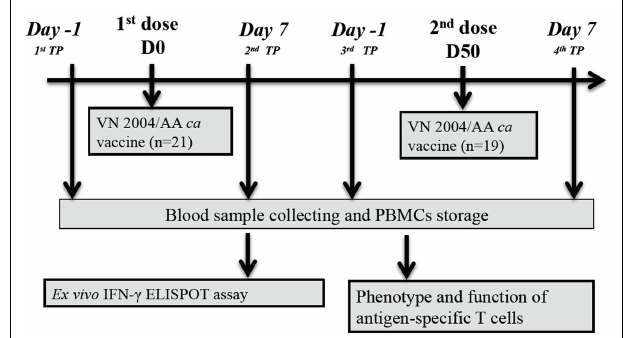
FIGURE 1 | Flow diagram of the clinical trial study design